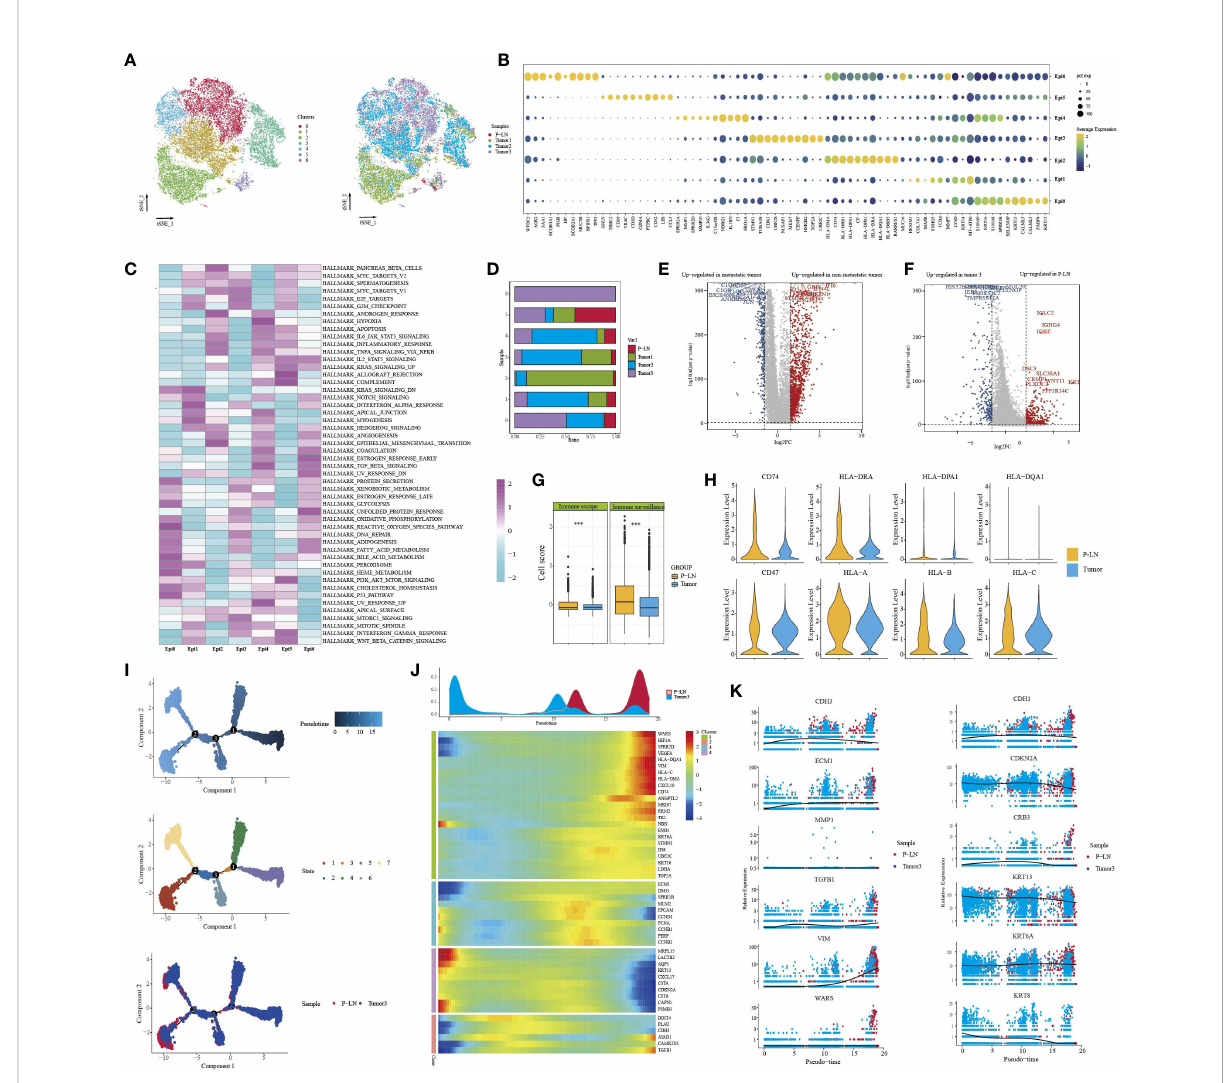
FIGURE 2 Characteristics of epithelial cells in the primary tumor and metastatic lymph node. tSNE of epithelial cells, with each cell color-coded for (left to right) the seven clusters of all cells and the corresponding samples (A) . Dot plot of representative genes in each cluster (B) . Differences in pathway activity (scored per cell by GSVA) in seven tumor cell clusters (C) . The proportion of each cell cluster in four samples (D) . Volcano plot showing differentially expressed genes of epithelial cells between metastatic tumors (tumor 3) and non-metastatic tumors (tumors 1 and 2) (E) . Volcano plot showing differentially expressed genes of epithelial cells between metastatic LN (P-LN) and primary tumor (tumor 3) (F) . Boxplots showing the differences of immune escape and immune surveillance score between P-LN and tumor (***P < 0.001) (G) . Violin plot showing the differences of signi fi cant genes between metastatic LN (P-LN) and primary tumor (tumor 3) (H) . Pseudotime analysis of epithelial cells predicated by Monocle 2. Each point corresponds to a single cell, and the color of the dot is distinguished by different times (up), different states (middle), and different samples (down) (I) . Heatmap showing dynamic changes in gene expression along the pseudotime (lower panel). Distribution of epithelial cells during the transition along with the pseudotime. Samples were labeled by colors (upper panel) (J) . Two- dimensional plots showing the expression scores of genes related to EMT along with the pseudotime (K)